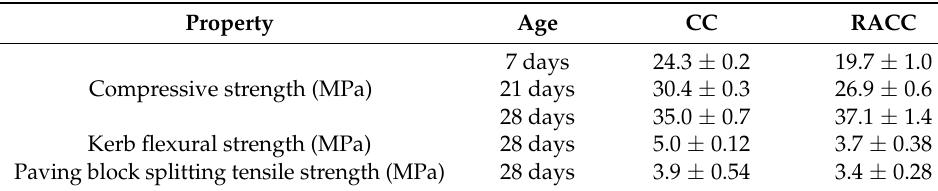
Table 9. Mechanical strength of conventional and recycled concrete.